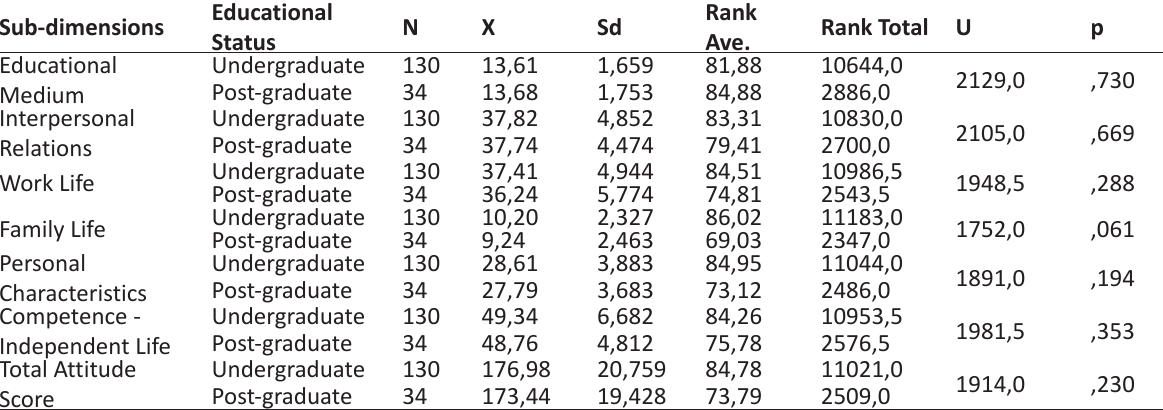
Table 5. Comparison of the Attitudes of the Participants towards the Handicapped according to Educational Status Sub-dimensions